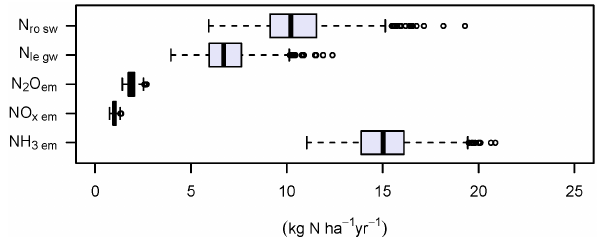
Fig. 3. Boxplots with 95% prediction interval and outliers of the area-weighted average (per NCU) N 2 O emission (N 2 O em ) , NO x emission (NO x em ) , NH 3 emission (NH 3 em ) , N leaching to ground- water (N le gw ) and N runoff to surface water (N ro sw ) for the EU27 for the year